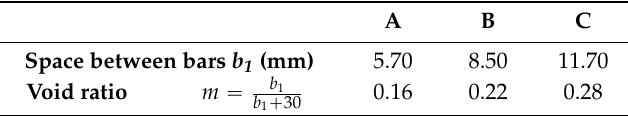
Figure 3. Intake system physical device in the Universidad Politécnica de Cartagena. Table 2. Geometric characteristic of racks in the physical device.